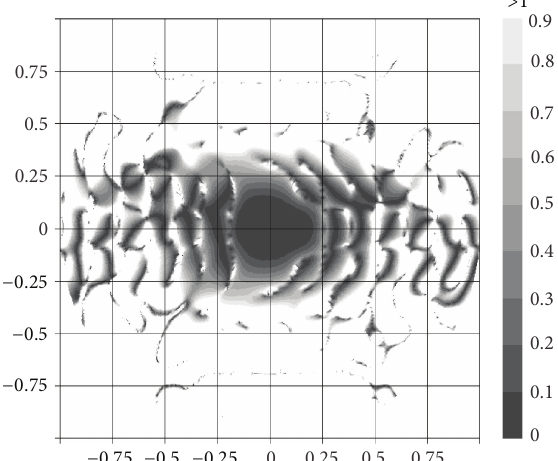
Figure 15: Differences between the required and designed radiation pattern (both in dB scale) for the 10×10 planar array with an arrow- shaped radiation pattern in the u - v